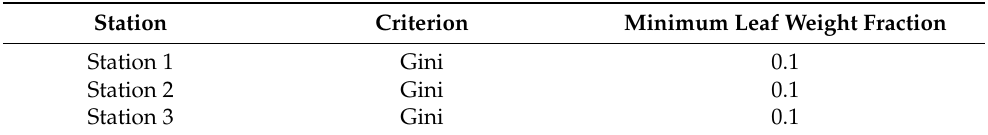
Table 5. Hyperparameters with the lowest error score for the decision tree algorithm selected by 5-fold cross validation grid search.